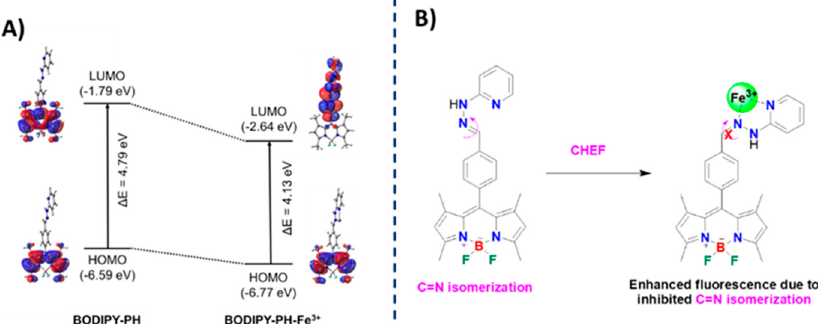
Figure 12. ( A ) Frontier molecular orbitals (HOMO and LUMO) of BODIPY-PH and BODIPY-PH-Fe 3+ compounds and their corresponding energy gaps ( ∆ E in eV) computed by BHandHLYP/6-311G* level of theory. The HOMO and LUMO orbitals are plotted with isovalue of 0.02. ( B ) Proposed sensing mechanism of BODIPY-PH upon Fe 3+ binding.